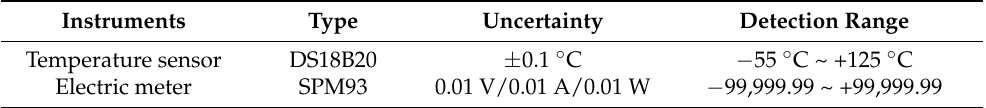
Table 3. Types and uncertainty of the test